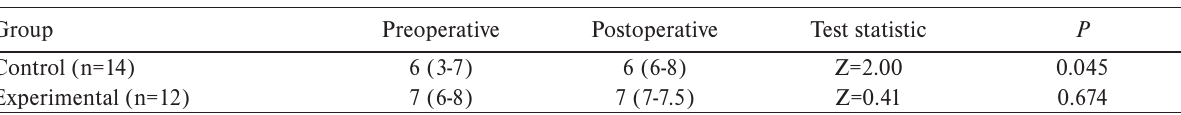
Fig. 2. Preoperative and postoperative state anxiety levels in patients from the experimental and control group (results presented as mean, median; the limits of the box show the interquartile range). Table 4. Preoperative and postoperative state anxiety levels in patients with high trait anxiety (≥7 sten) from the control and experimental